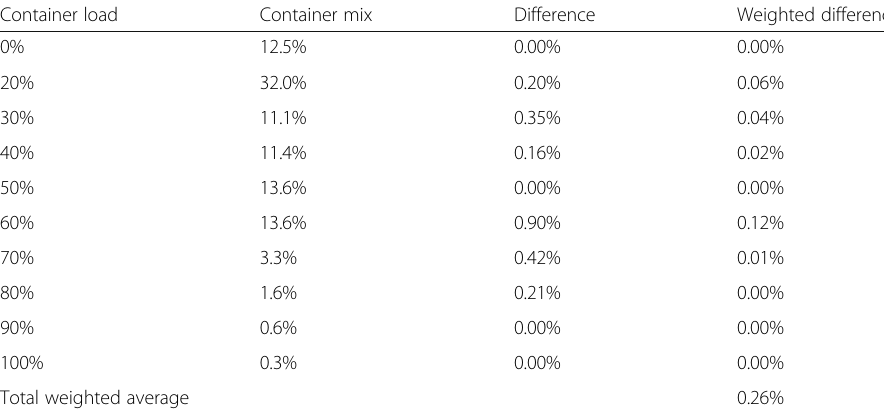
Table 1 Weighted difference for difference in energy demand Container load Container mix Difference Weighted difference